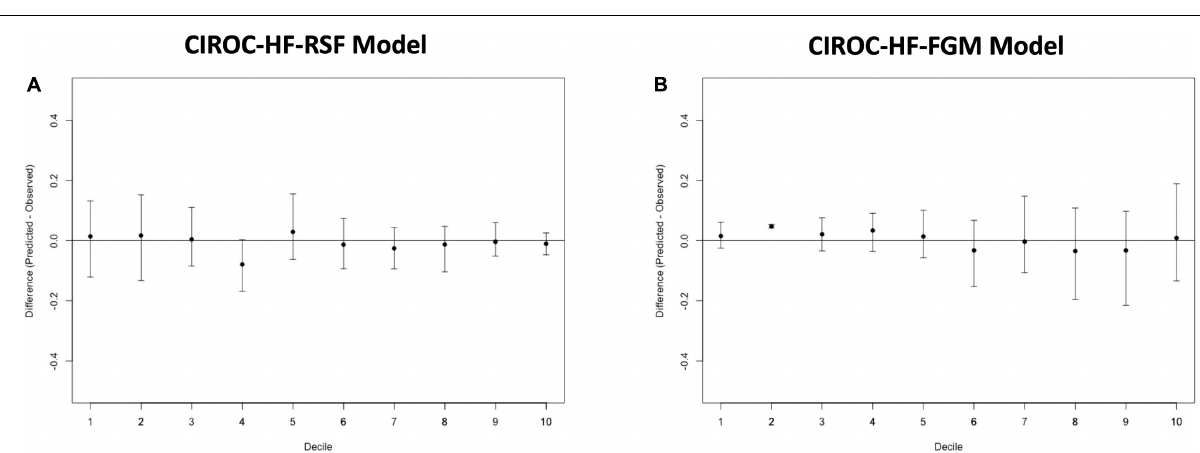
FIGURE 3 | Calibration plots for (A) CIROC-HF-RSF risk model, and (B) CIROC-HF-FGM risk model for the prediction of HF hospitalization in the holdout cohort. Plots display difference between observed and expected event rates at each decile of risk. Confidence intervals are derived from 100 bootstrapped